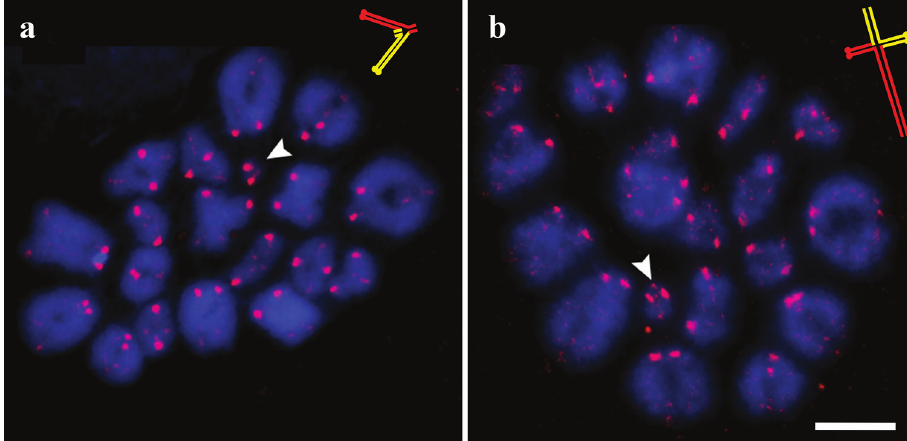
Figure 3. Meiotic metaphase I in sand lizards. a standard karyotype b heterozygote for the long variant of SC 19. Arrowheads and schematic inserts show bivalent 19. In schematic inserts red and yellow colors show the homologues. Red: SYCP3. Blue: DAPI. Scale bar: 10 µm.